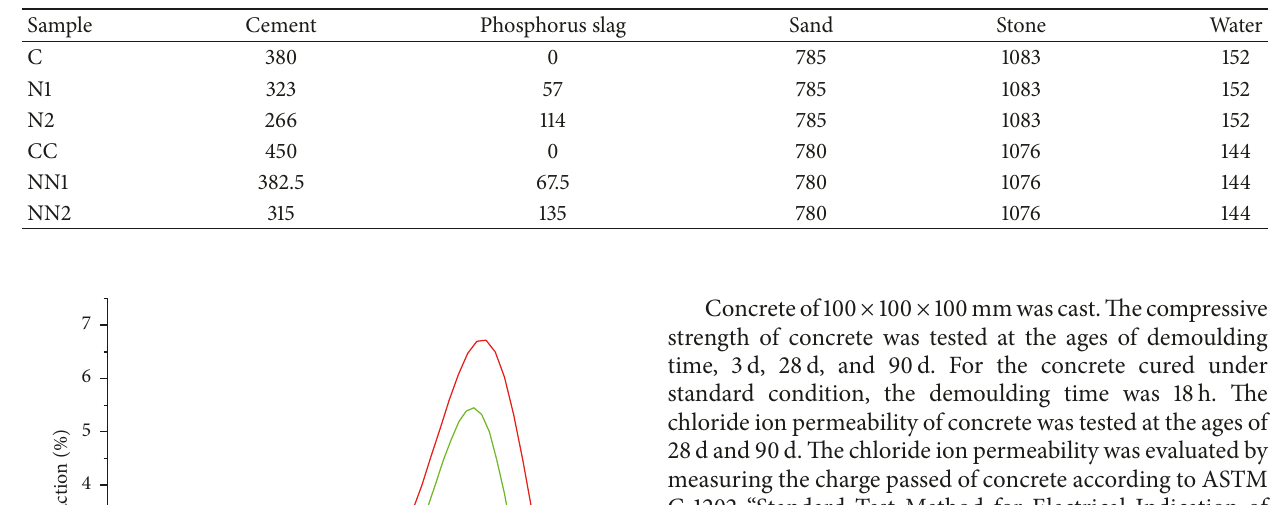
Table 2: Mix proportions of concrete/kg ⋅ m −3 .